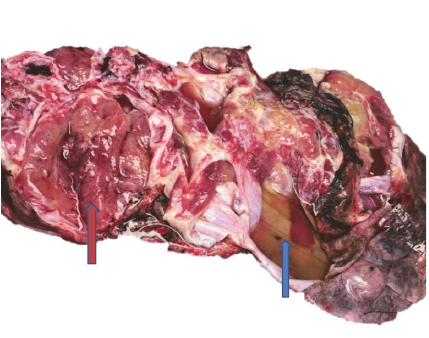
Figure 2: Sections from the tumor show networks of anastomosing slit-like to cystic spaces lined by cuboidal Sertoli cells, resembling the rete testis. Some of the retiform tubules are denoted by blue arrows (H&E, 100x).